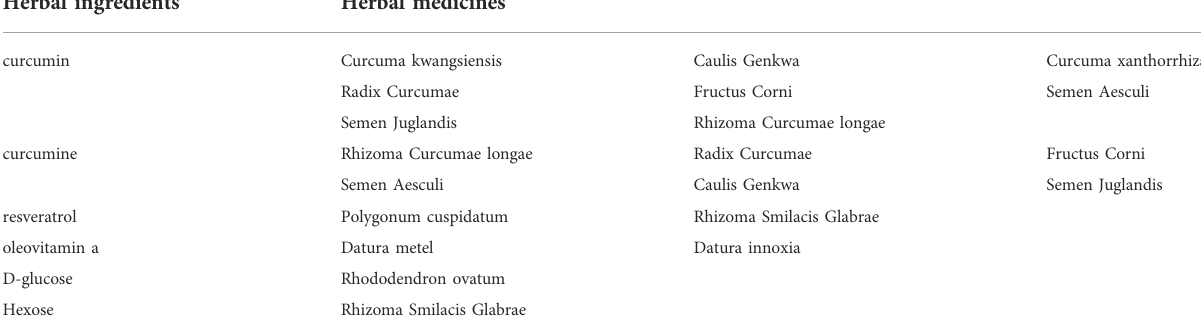
TABLE 4 List of 14 herbal medicines and six herbal ingredients predicted in this study. Herbal ingredients Herbal